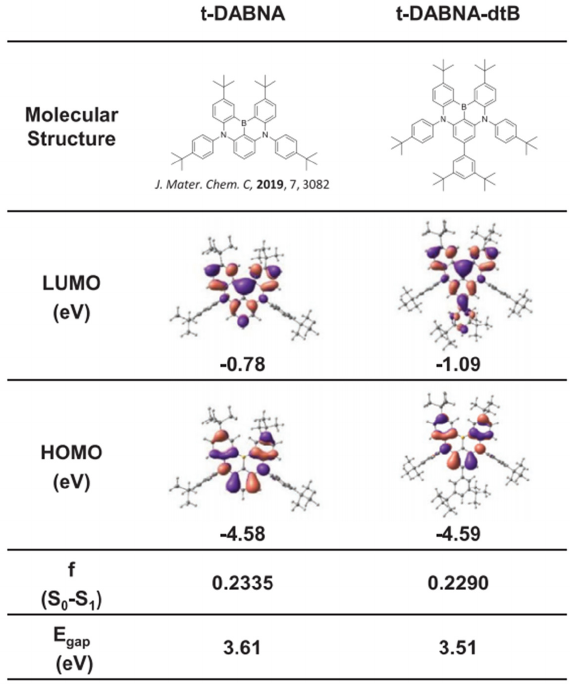
Figure 3. Molecular structures and DFT calculations of t-DABNA and t-DABNA-dtB. Reproduced with permission from Jinho Park, Ki Ju Kim, Junseop Lim et al., “High Efficiency of over 25% and Long Device Lifetime of over 500 h at 1000 nit in Blue Fluorescent Organic Light-Emitting Diodes”; published by John Wiley and Sons , 2022 [49].